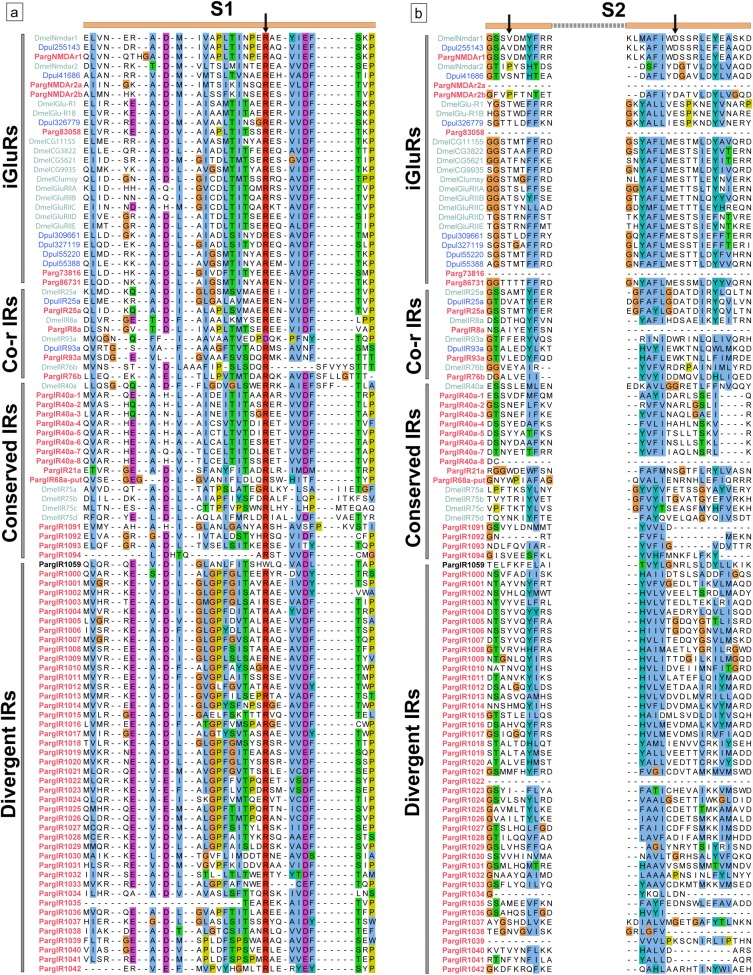
Multiple sequence alignment of iGluRs and IRs of Parg, Dmel, and Dpul.This analysis shows that the LBD is highly divergent within the IRs and in comparison to iGluRs. Parg (red), Dmel (mint), and Dpul (blue) sequences are organized based on sequence homology in Fig 2. Divergent IR, PargIR1059, an exception to ‘R’ conservation in S1 lobe, is indicated in black. Glutamate binding sites are indicated with arrows. (a) S1 lobe of LBD. (b) S2 lobe of LBD. The sequences were aligned with MAFFT and visualized on Jalview. The residues were colored according to the Clustal X color scheme on Jalview. Criteria for the color scheme: http://www.jalview.org/help/html/colourSchemes/clustal.html.